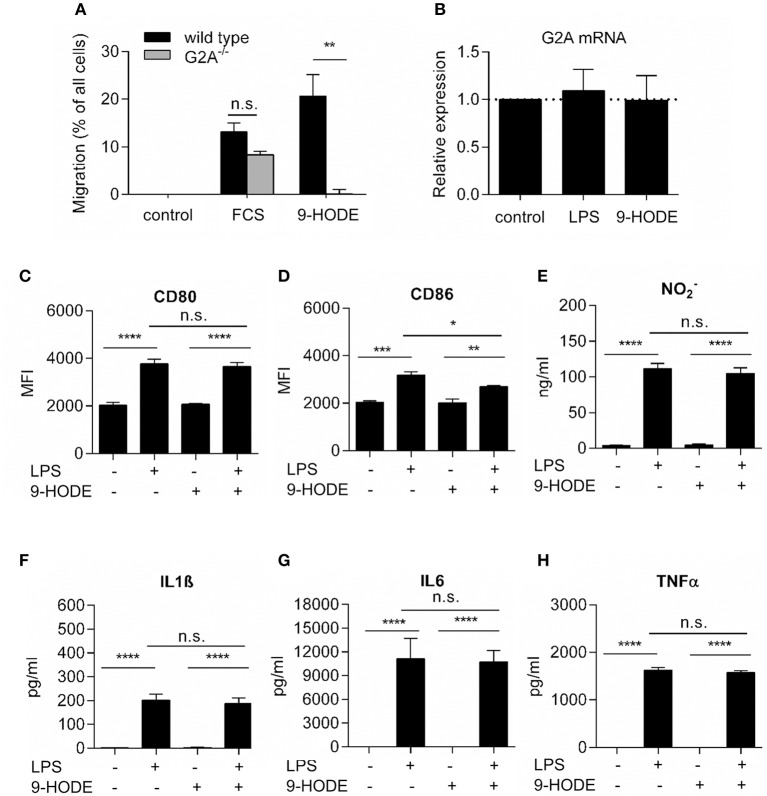
G2A-activation does not alter proinflammatory markers in bone marrow-derived macrophages. (A) G2A-mediated macrophage migration. Data are shown as mean ± S.E.M. (n = 3–4). Migration of BMDMs from wild type and G2A−/− mice was not induced (control) or induced by serum and 9-HODE. Unpaired two-tailed Student‘s t-test. **p < 0.01 as compared to control. (B) RT-PCR analysis for G2A expression in BMDM, differentiated for 7 days with 20 ng/ml M-CSF and stimulated with 100 ng/ml LPS or 1 μM 9-HODE for 24 h. Data are shown as 2(−ΔΔCT), mean ± S.E.M. (n = 4). (C–H) Marker expression by bone marrow-derived macrophages from wild type mice after stimulation with 100 ng/ml LPS or 1 μM 9-HODE for 24 h. CD80 and CD86 expression were analyzed by FACS, nitrite using the Griess test and IL1β, IL6, and TNFα by ELISA. Data are shown as mean ± S.E.M. (n = 4–5). One-Way ANOVA with Bonferroni post-hoc Test *p < 0.05, **p < 0.001, ***p < 0.0001, ****p < 0.00001.